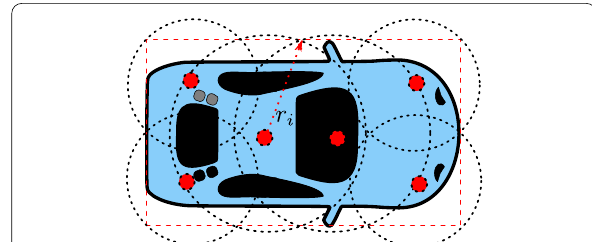
Figure 9 Six covered circles of the vehicle